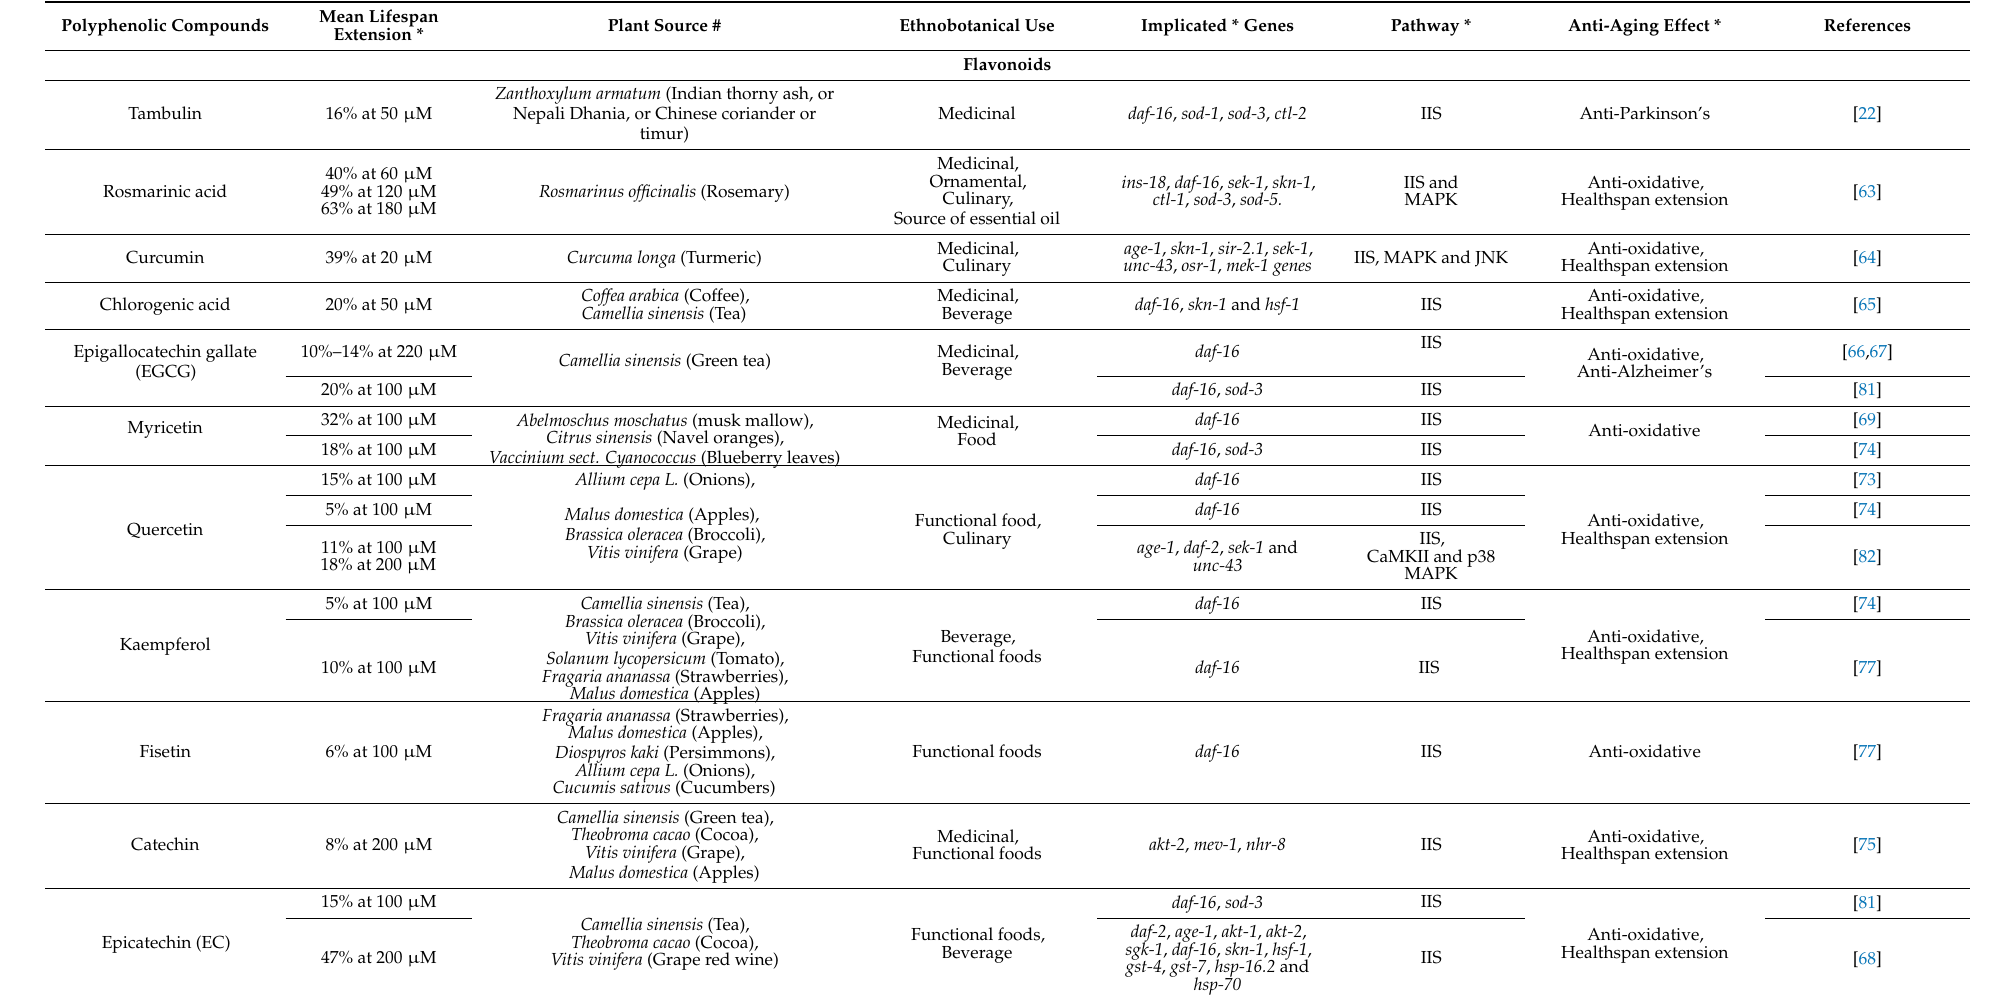
Table 1. Polyphenolic compounds with anti-aging and lifespan extending properties as demonstrated in the C. elegans